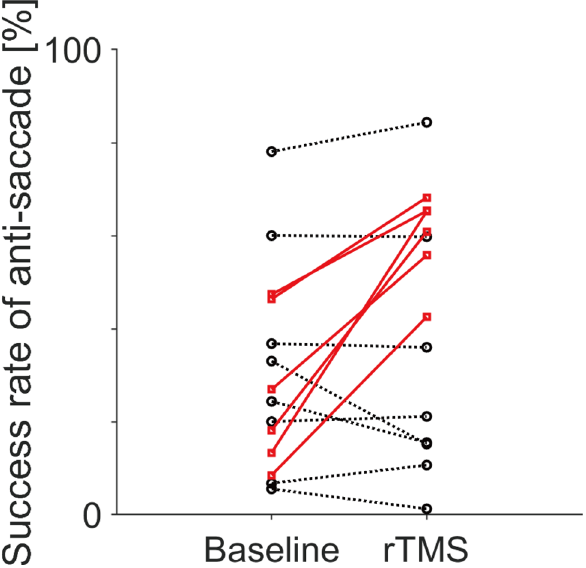
Figure 3. Individual changes in anti-saccade success rates. Baseline and post-rTMS performances are shown on the left and right, respectively. Lines connect data from the same individual. Solid red lines indicate significant improvement in the success rate (binomial test, p < 0.05) while dotted black lines indicate no significant post- rTMS improvements.